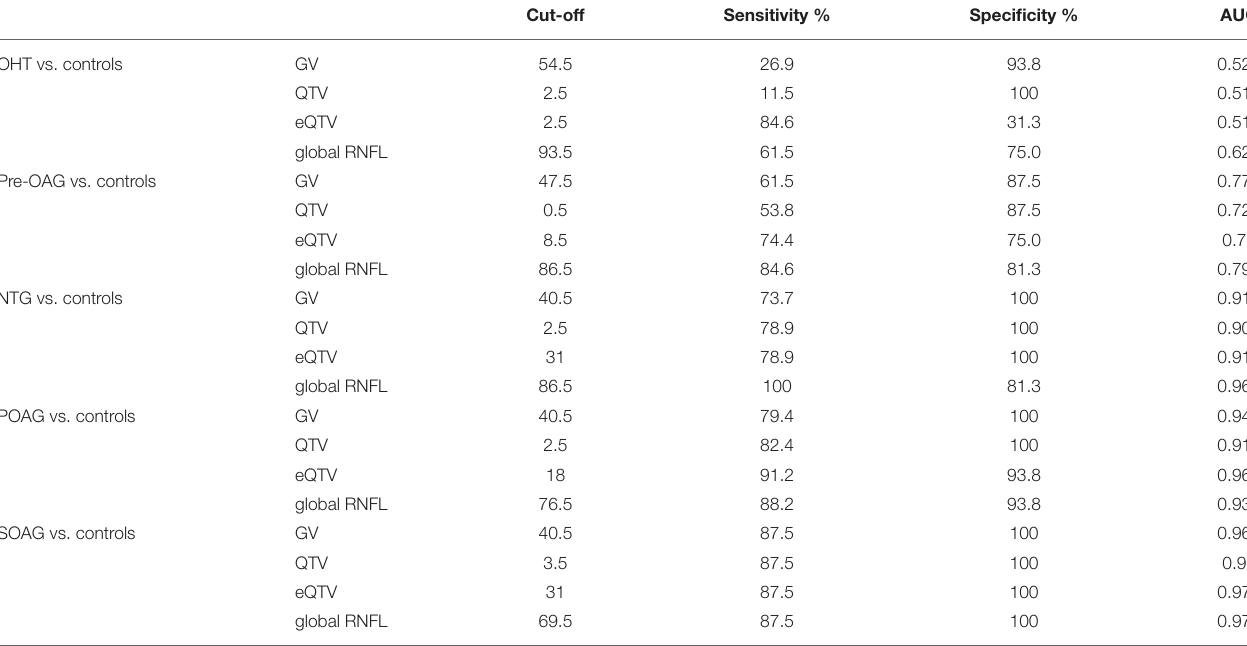
TABLE 9 | Sensitivity, specificity and AUCs of ROC for GV [ µ m], QTV, eQTV, and global RNFL [ µ m] for OHT, pre-OAG, NTG, POAG, and SOAG vs. controls, respectively. Cut-off Sensitivity % Specificity % AUC OHT vs.